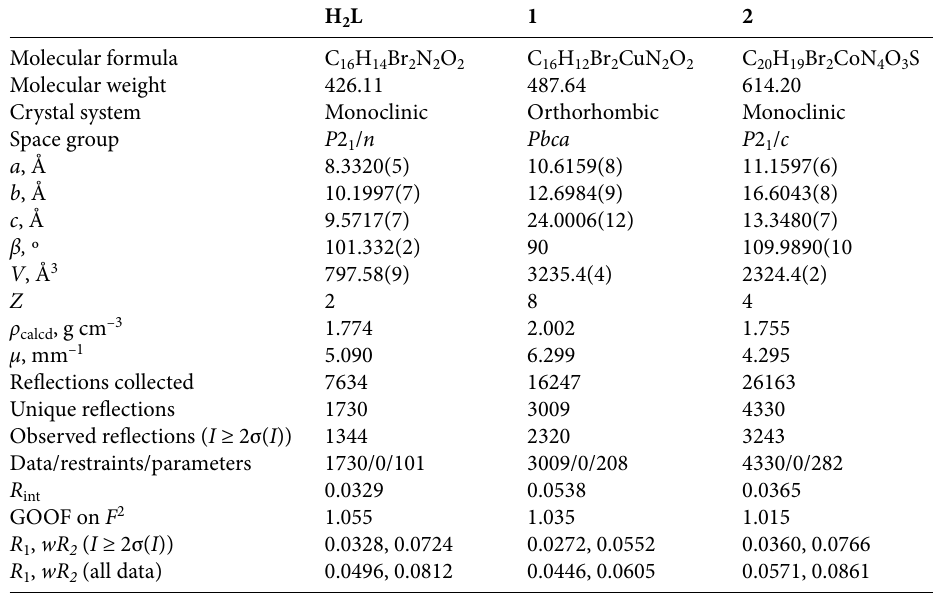
Table 1. Crystallographic data and refinement details for the compounds